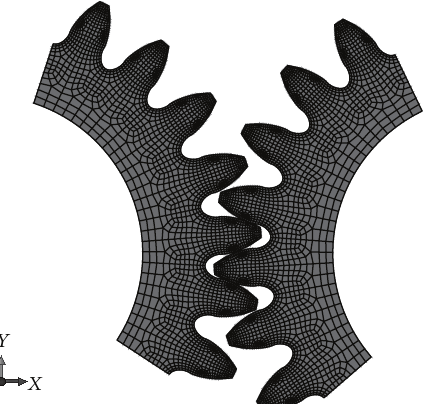
Figure 4: Gear geometry and contact